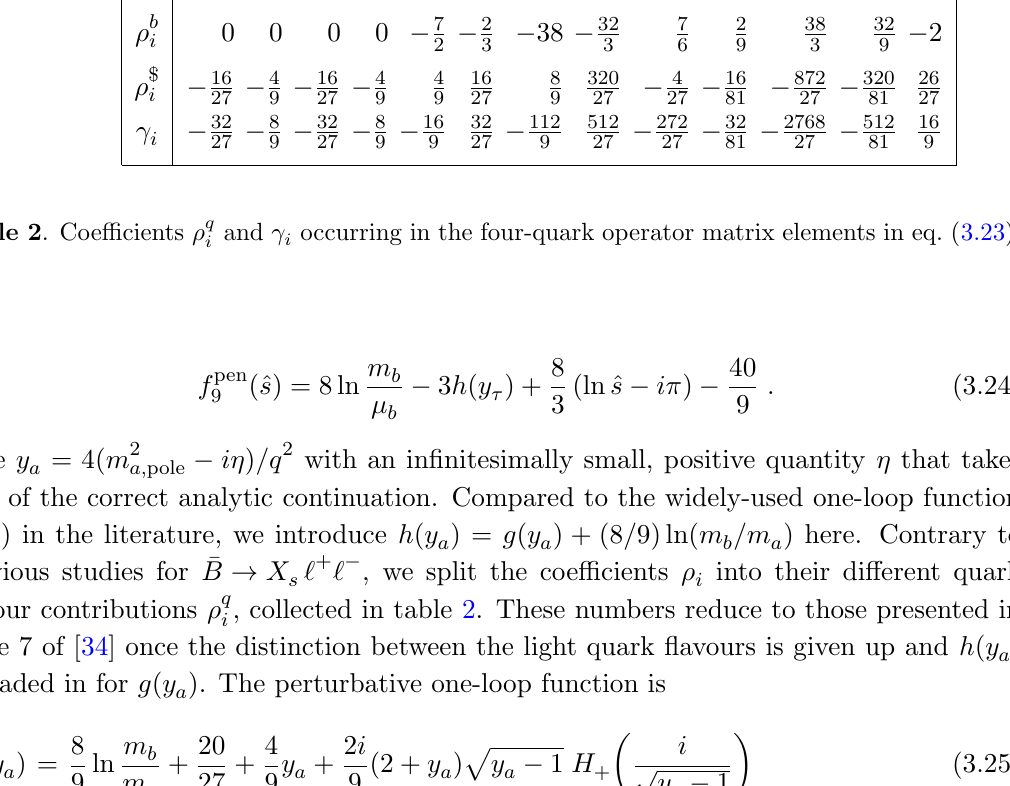
Table 2 . Coe(cid:14)cients (cid:26) q